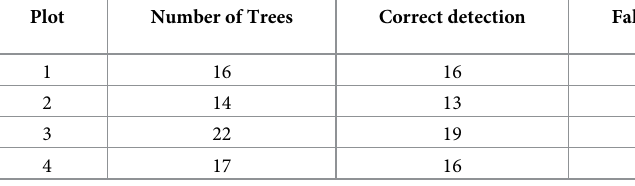
Table 2. The results of the trunk detection. Plot Number of Trees Correct detection False